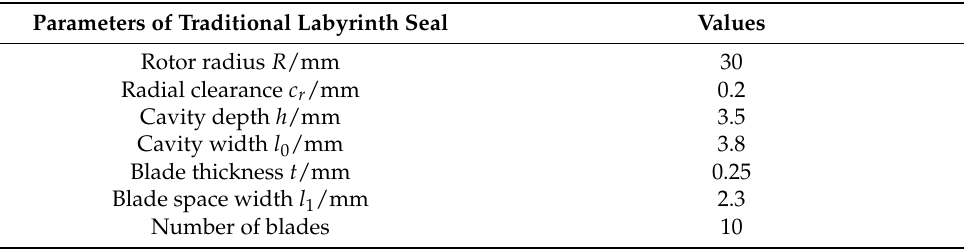
Figure 1. Sectional drawing of traditional LS structure. Table 1. Design parameters of LS in Ref [9] .